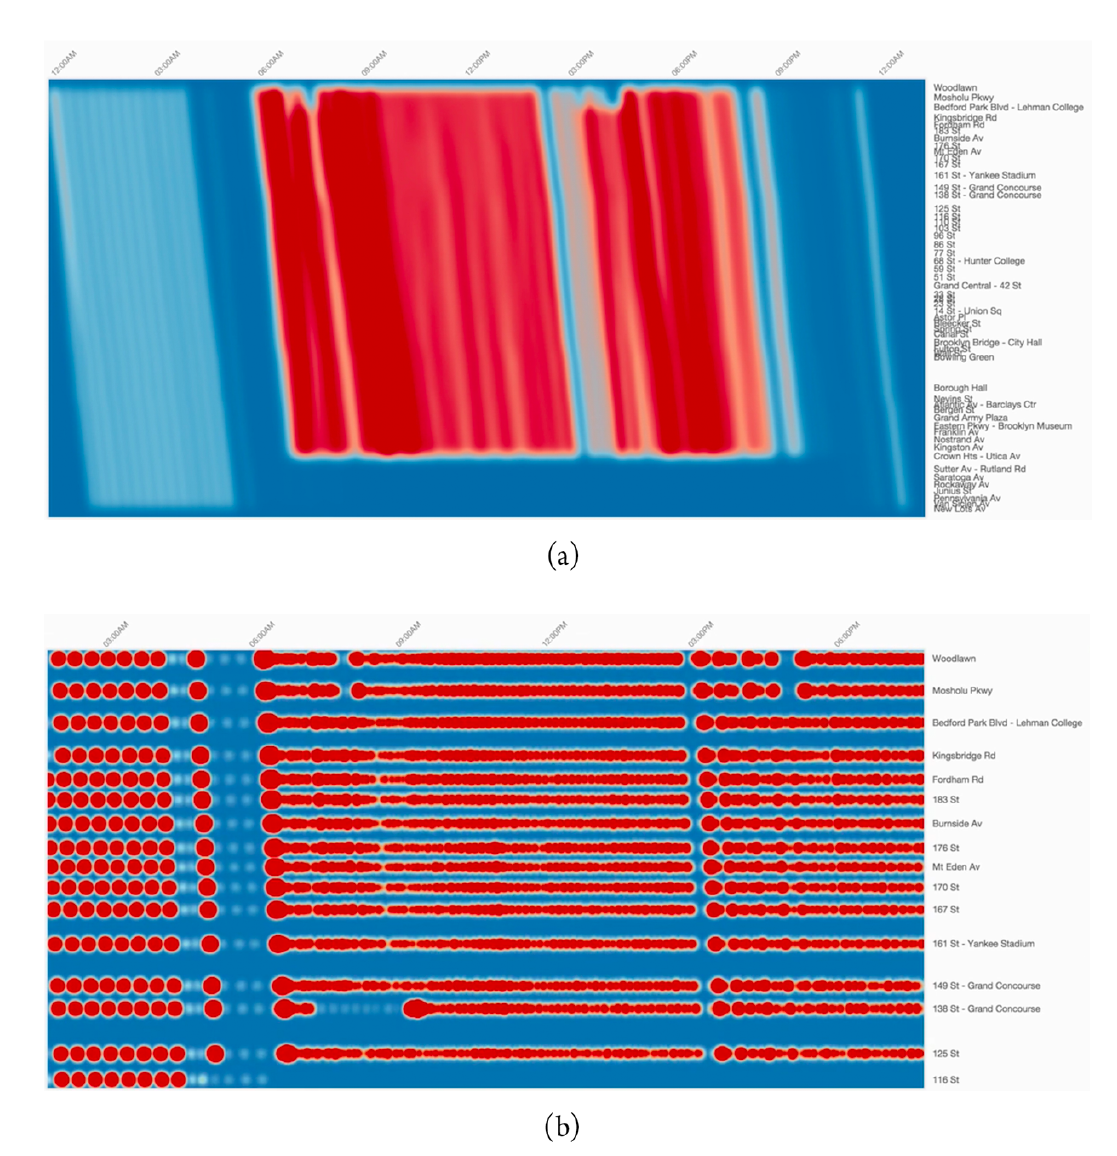
Figure 16. The Trips Explorer (TR-EX) online visualization tool for exploration of transportation schedules at trips and stops levels. Trips visualization is shown on ( a ), while stops visualization is shown on ( b ) with a different time window and reduced number of stops [67] (adapted from